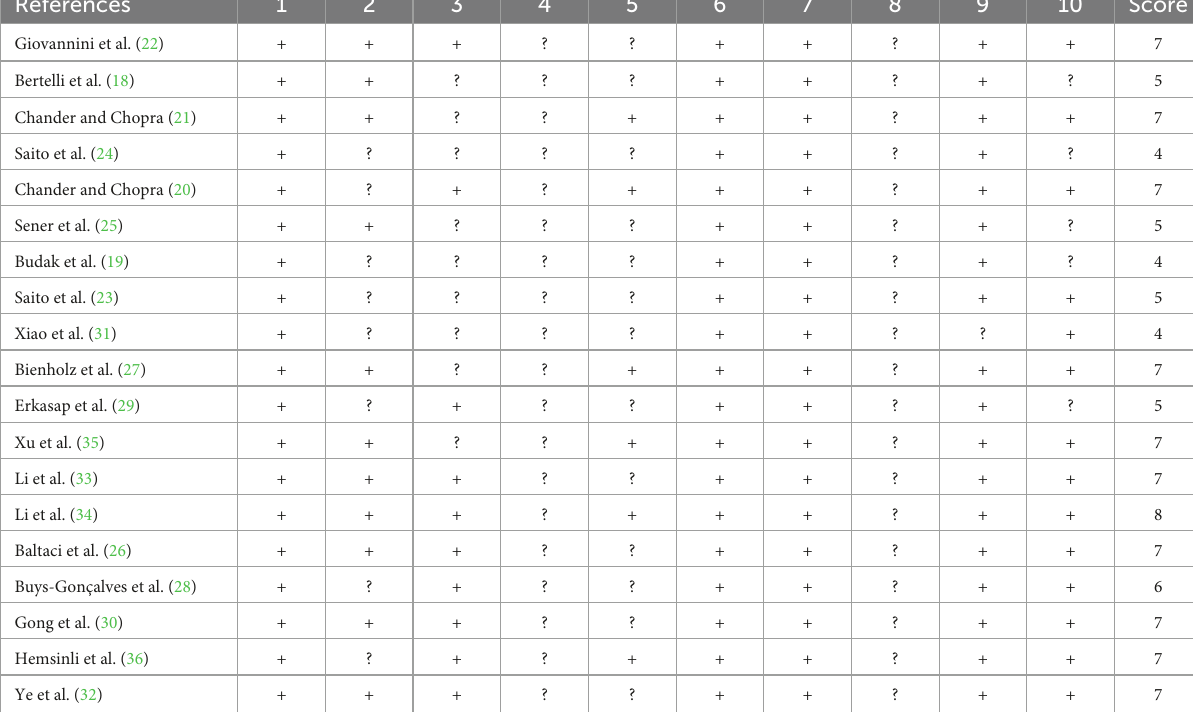
TABLE 2 The research quality of included